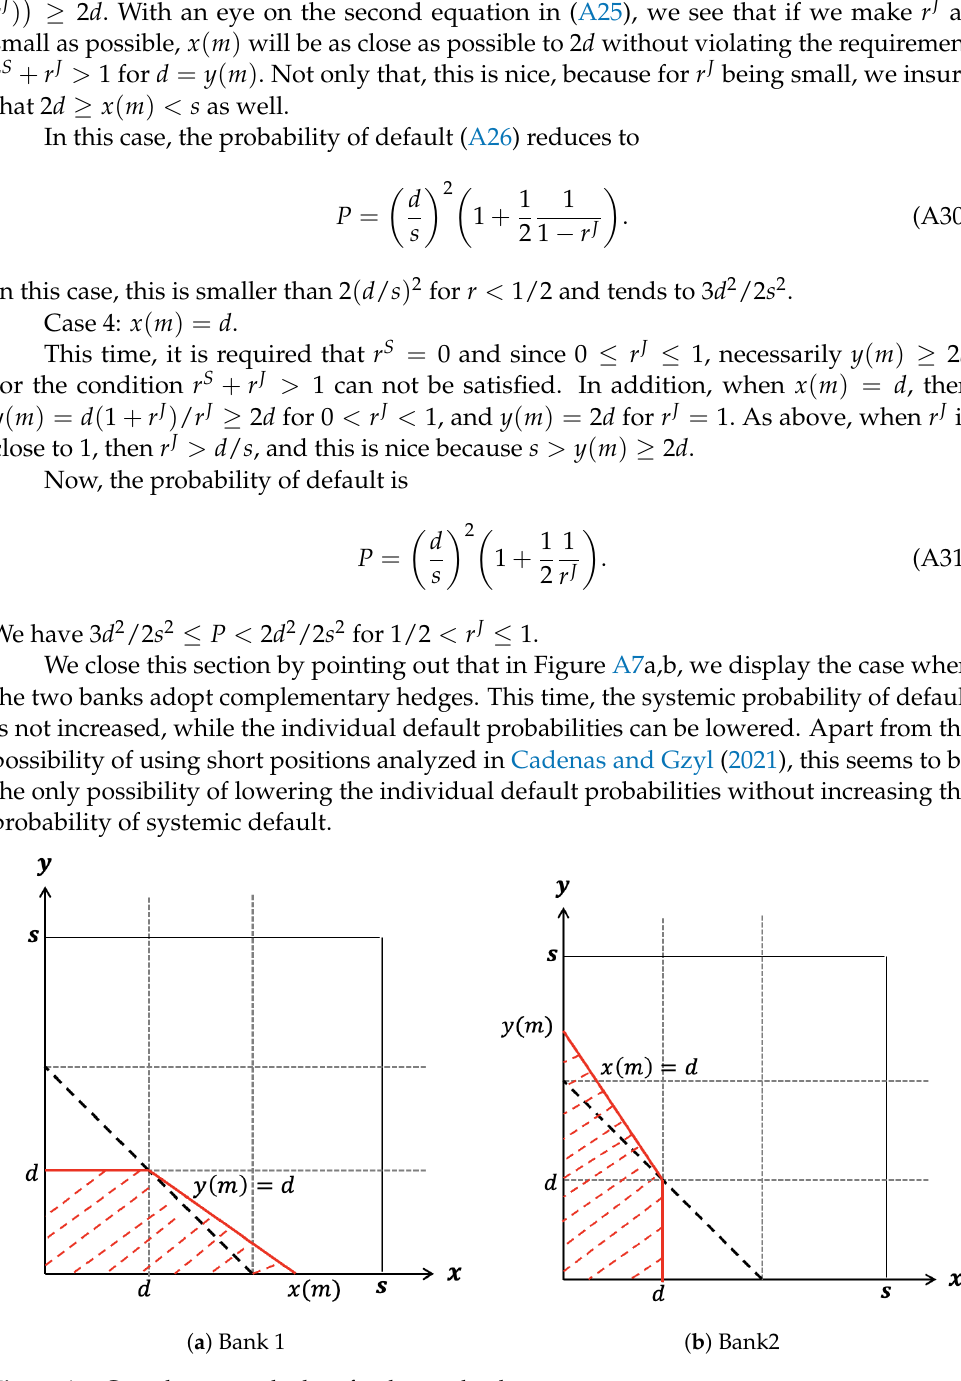
Figure A7. Complementary hedges for the two